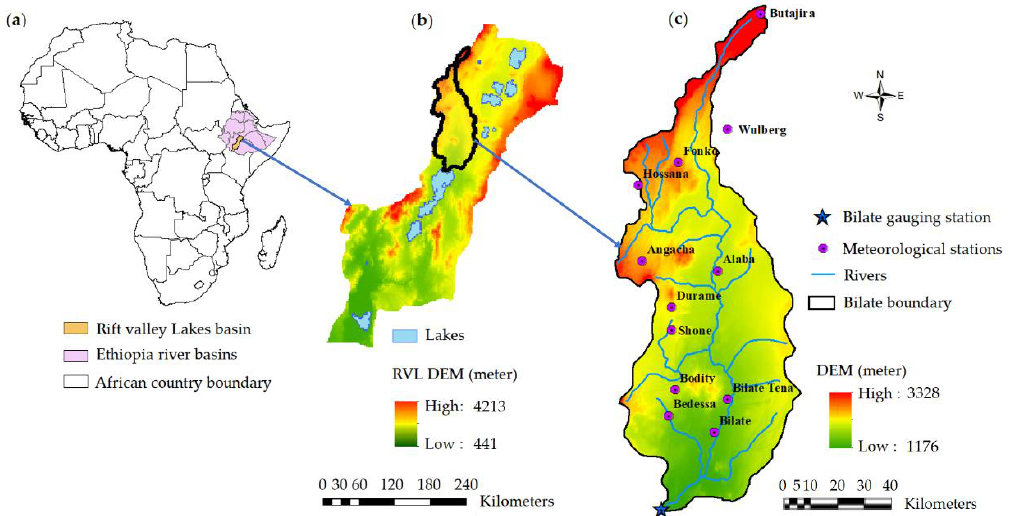
Figure 1. Map of the study area: ( a ) the continent of Africa; ( b ) the entire Rift Valley Lakes Basin; ( c ) DEM and meteorological stations of the Bilate watershed.